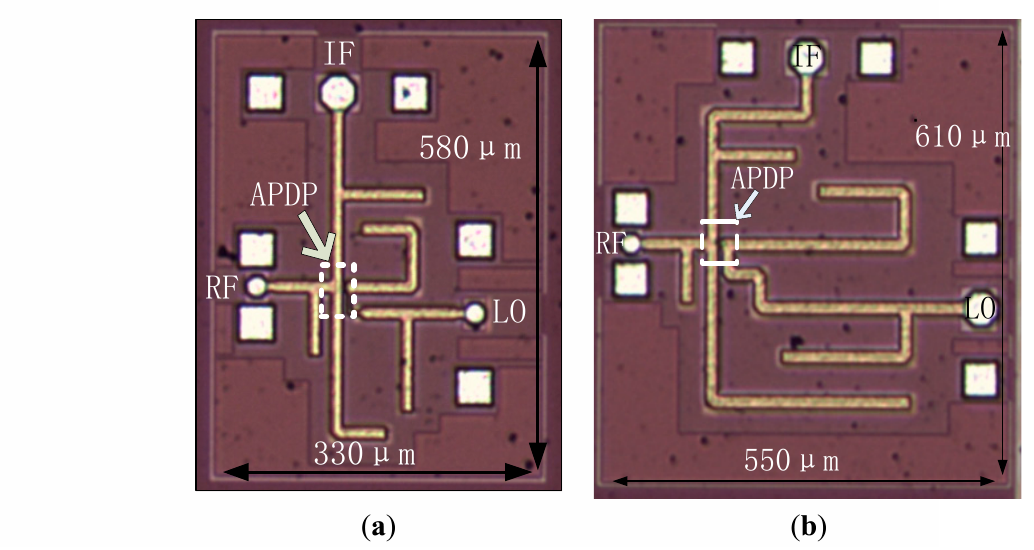
Figure 4. Die photographs of the 340 GHz SHMs: ( a ) 2× SHM and ( b ) 4×